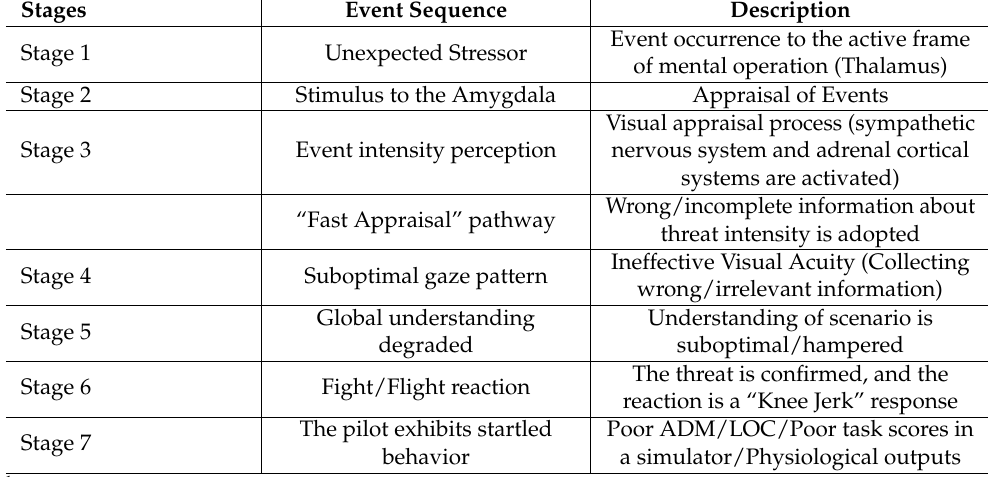
Table 1. “Fast appraisal” startle conceptualization for an unexpected “clear air turbulence” event 1